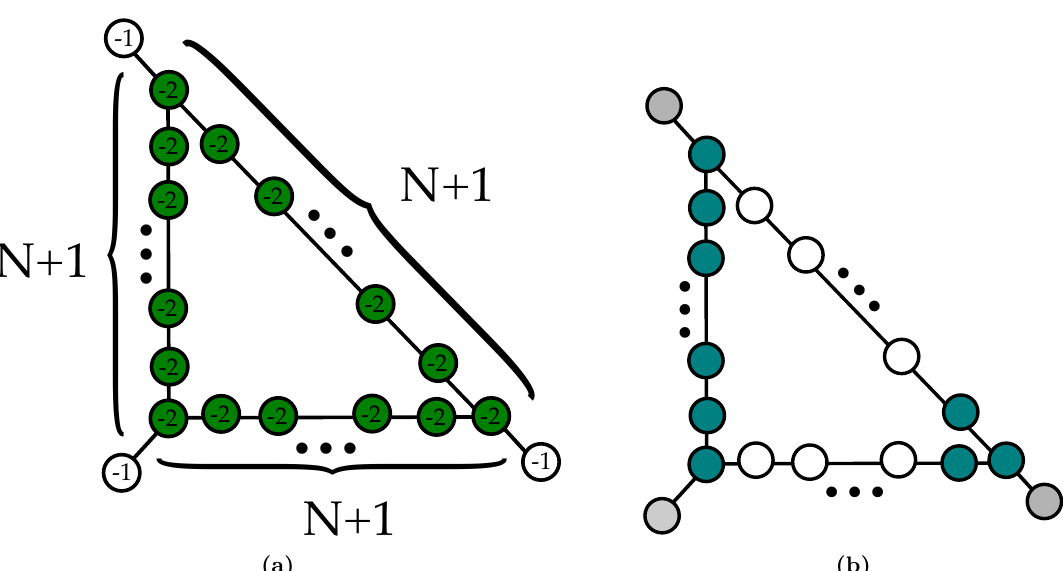
Figure 14 . (a) CFD for the marginal theory, which after three mass deformations results in the \ T N theory. It has (cid:13)avor symmetry SU(3 N ). (b) The weakly coupled description can be determined from the embedding of the IR-CFDs or BG-CFDs, which is shown here: the CFD allows embedding of the BG-CFDs for U( N + 2) (cid:2) SO(6), where the U( N + 2) arises from the left hand side of the diagram, and the SO(6) from the right hand